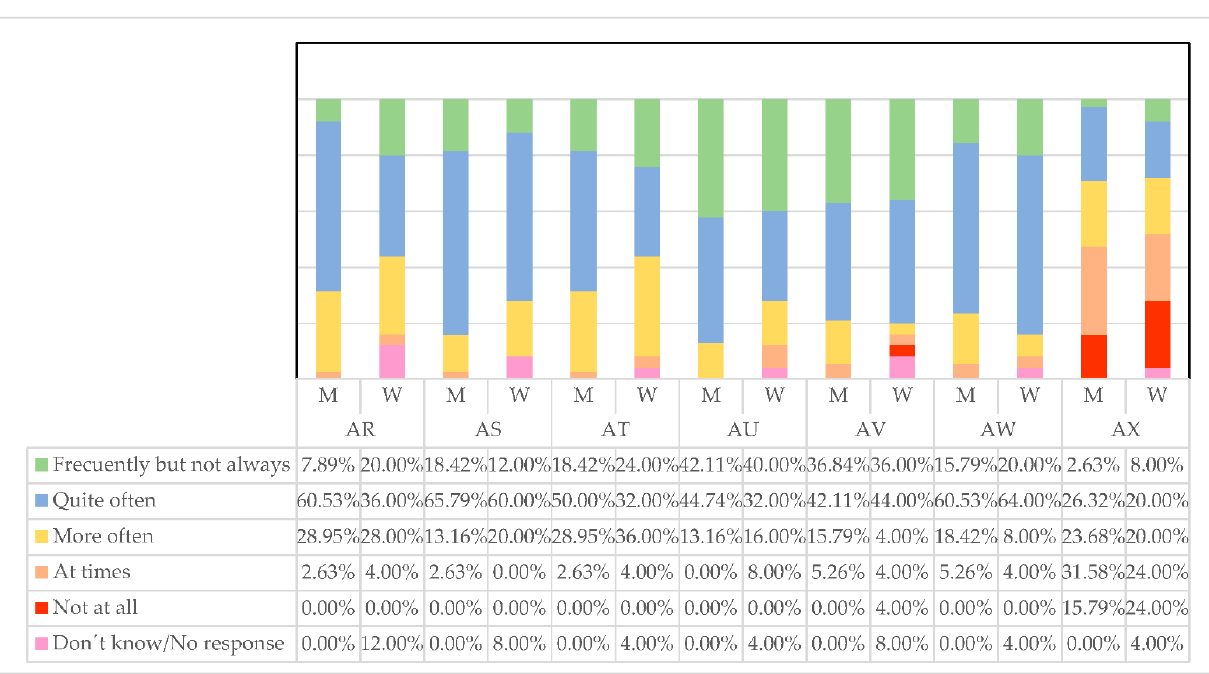
Figure 7. Qualities developed by managers. Source: own elaboration.